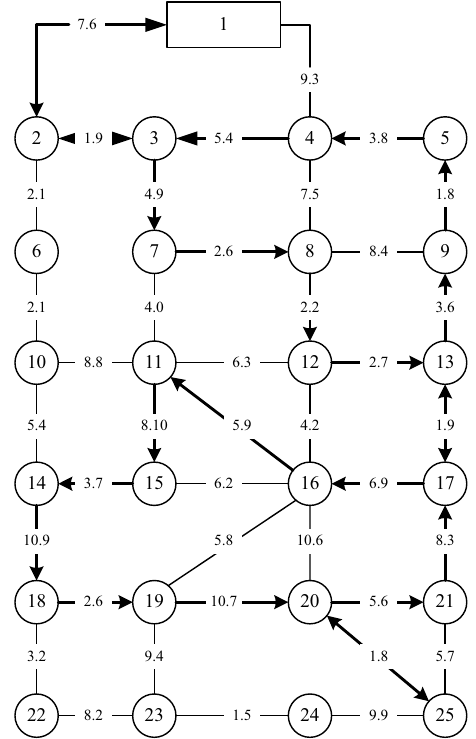
Fig. 5. The routing plan results of the proposed SA algorithm